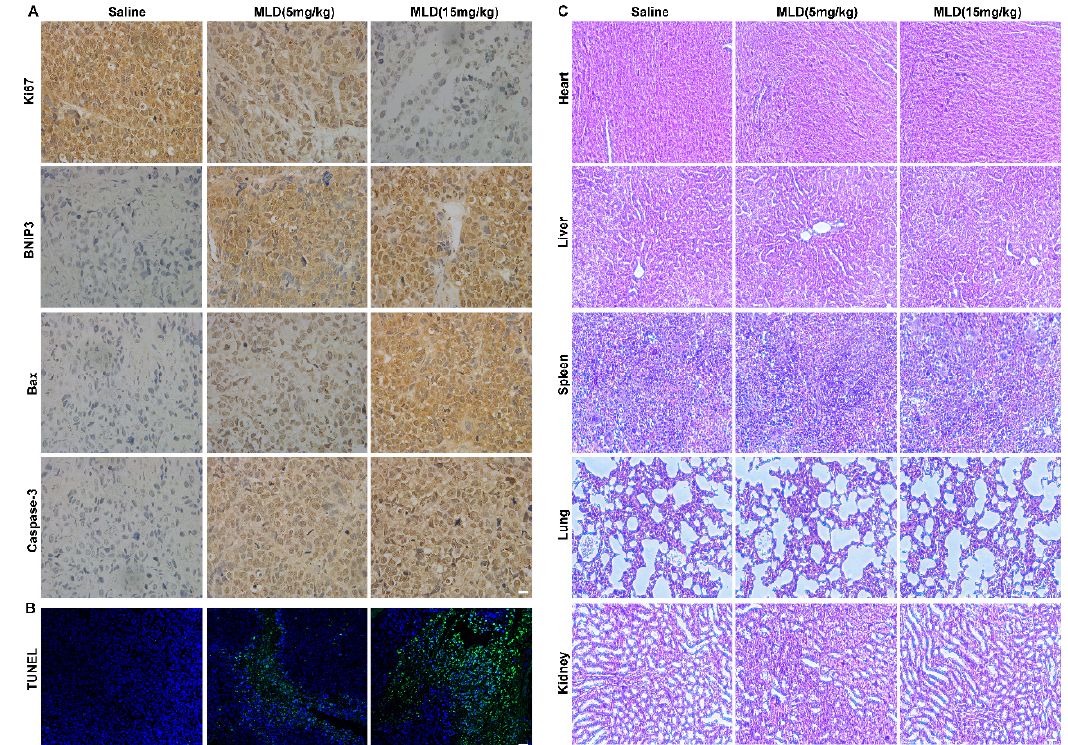
Figure 7. MLD promoted HepG2 cell death in vivo. ( A ) The levels of Ki67, BNIP3, Bax, and caspase-3 were detected by IHC. Scale bar: 100 μ m. ( B ) The apoptosis of HepG2 cells as determined by TUNEL assay. Scale bar: 150 μ m. ( C ) HE staining images of the main organs of mice (heart, liver, spleen, lung, and kidney). Scale bar: 100 μ m. The results are representative of three independent experiments and are expressed as the mean ± SD.